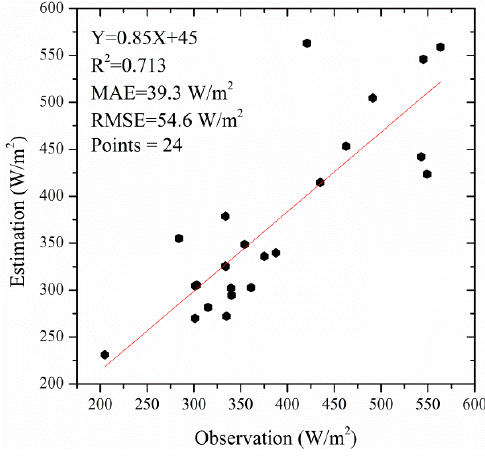
Figure 4. Comparison between ET observations from EC stations and ET estimates by the SEB-A method.